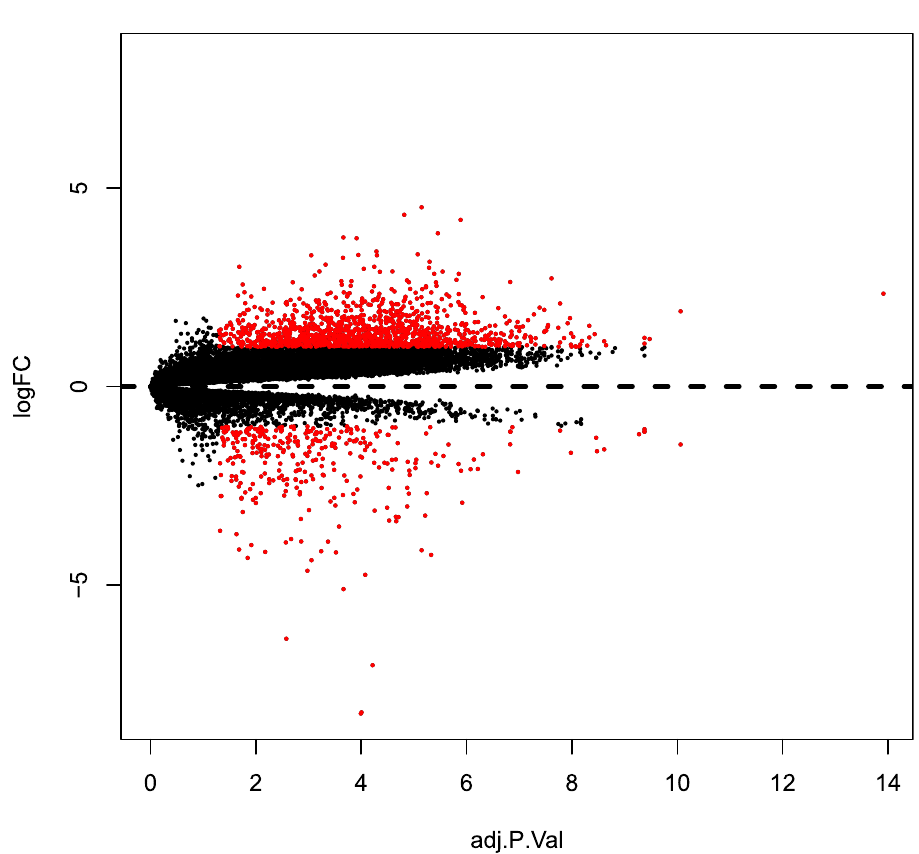
Figure 2. Volcanic map of DEGs, red color represents DEGs in GC including up-regulated and down-regulated genes. [The figure was created by Limma (http://www.bioco nduct or.org/packa ges/relea se/bioc/html/limma